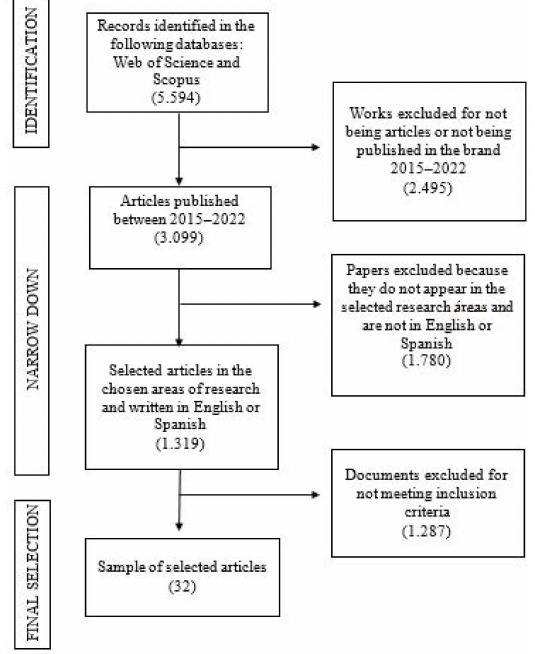
Figure 1. Flow chart.